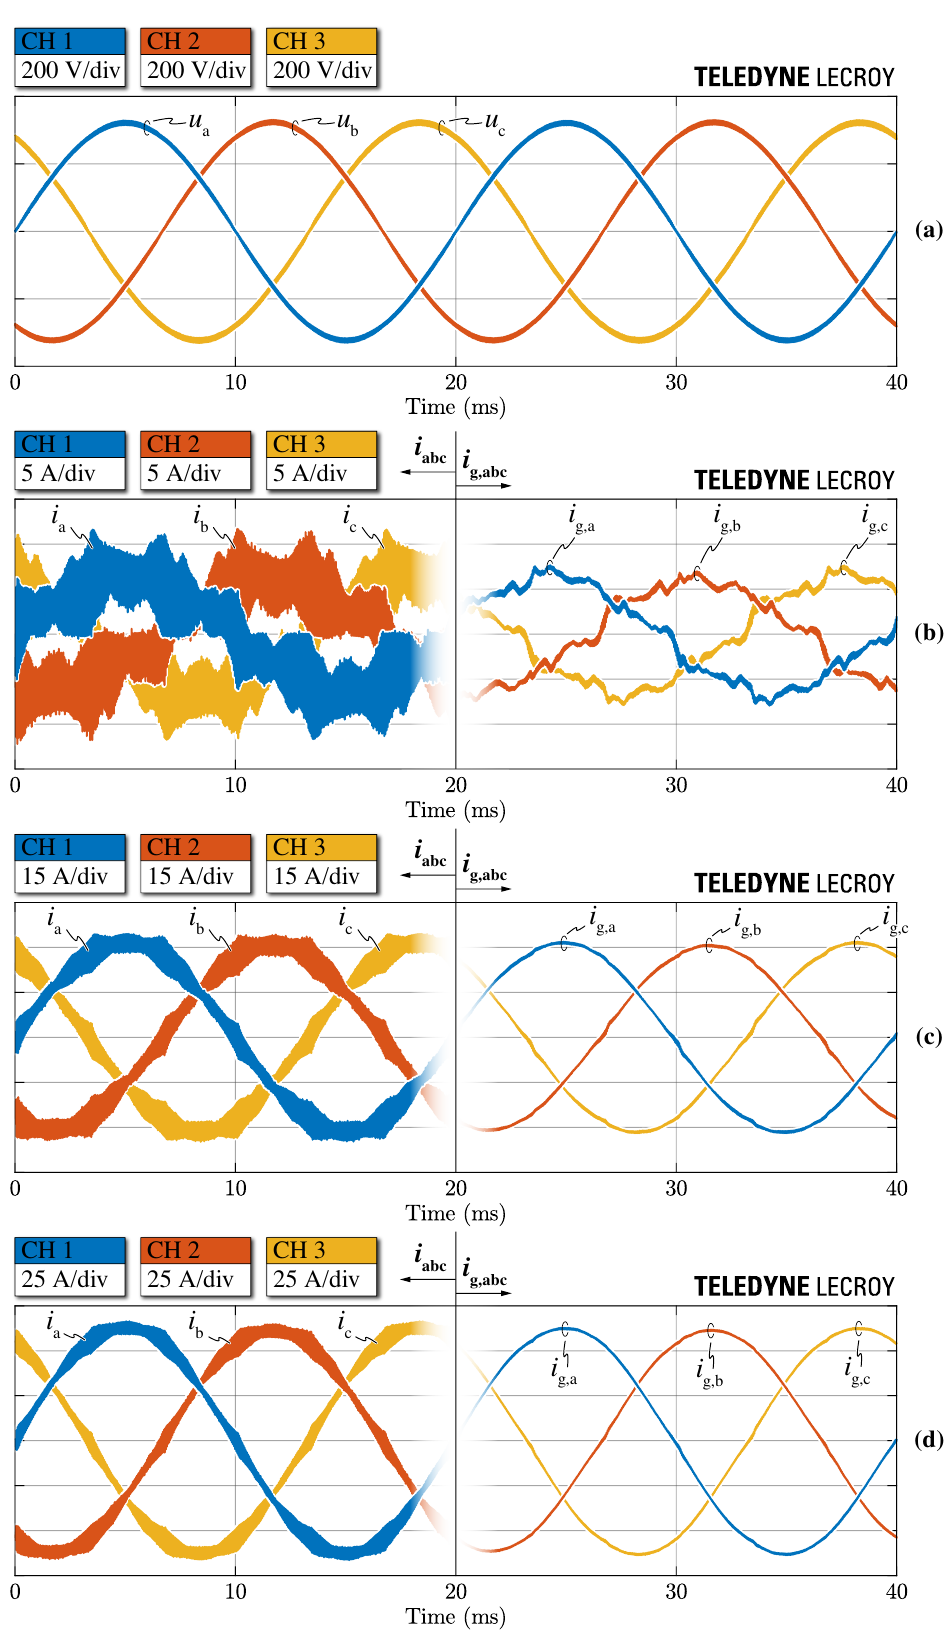
Figure 14. Experimental waveforms in steady-state conditions with V dc = 800V and ϕ = 0. Mea- sured grid voltages u abc ( a ) and both converter-side currents i abc and grid-side currents i g,abc at ( b ) 10%, ( c ) 50%, and ( d ) 100% of the nominal power (i.e., P =